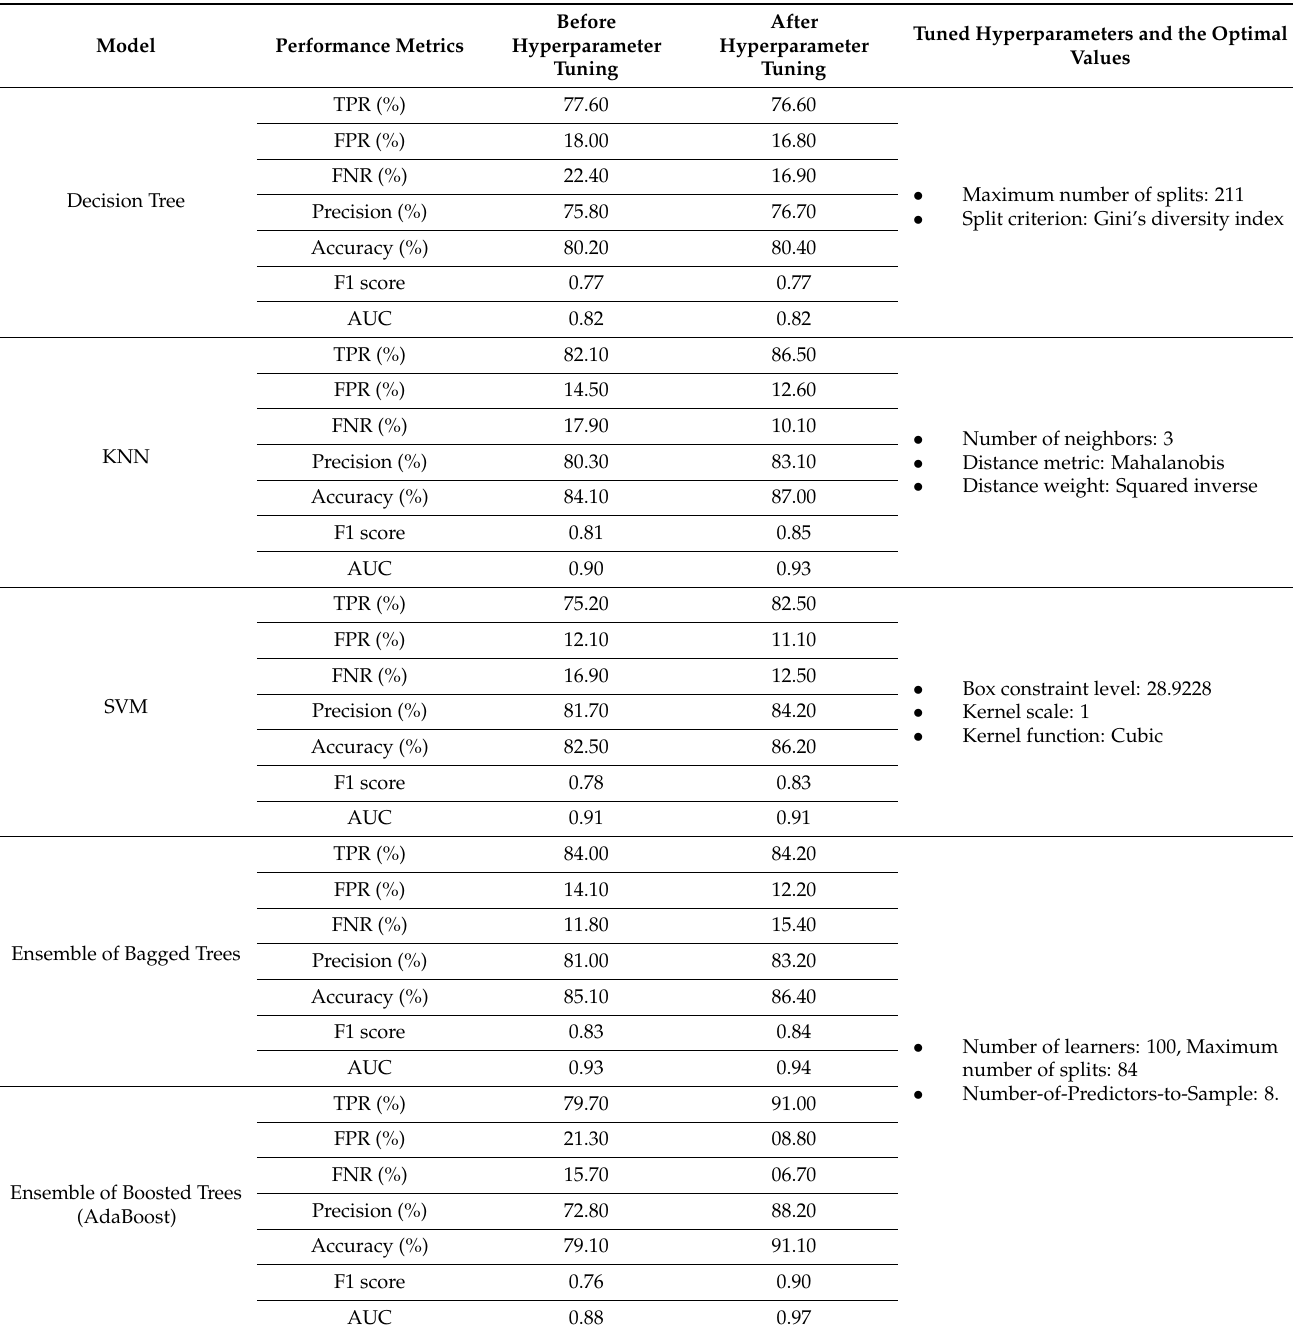
Table 4. Performances of the classification